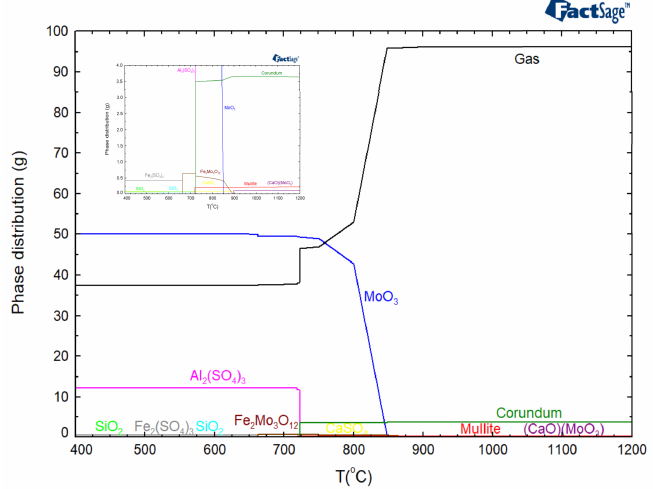
Figure 9. Thermodynamic calculation results of DCLR (ER) high-temperature